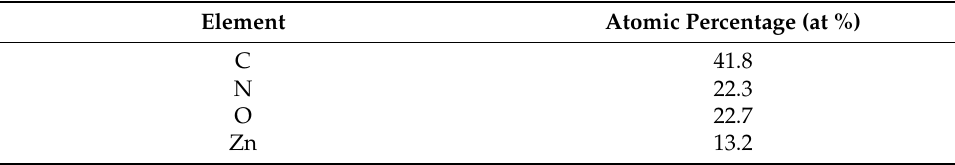
Table 2. Surface elemental composition of CNHP500-2(2-1) sample. Element Atomic Percentage (at